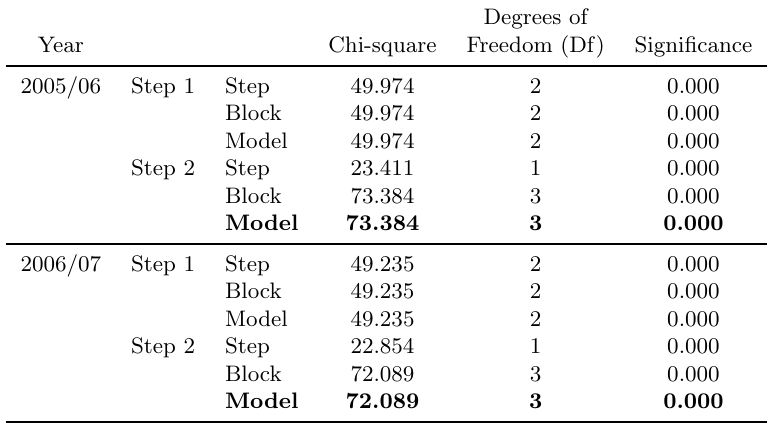
Table 5: Chi-square goodness-of-fit test for the resource allocation model for the South African Air Quality Units. P: Estimated probability for Air Quality Units; KM: Knowledge